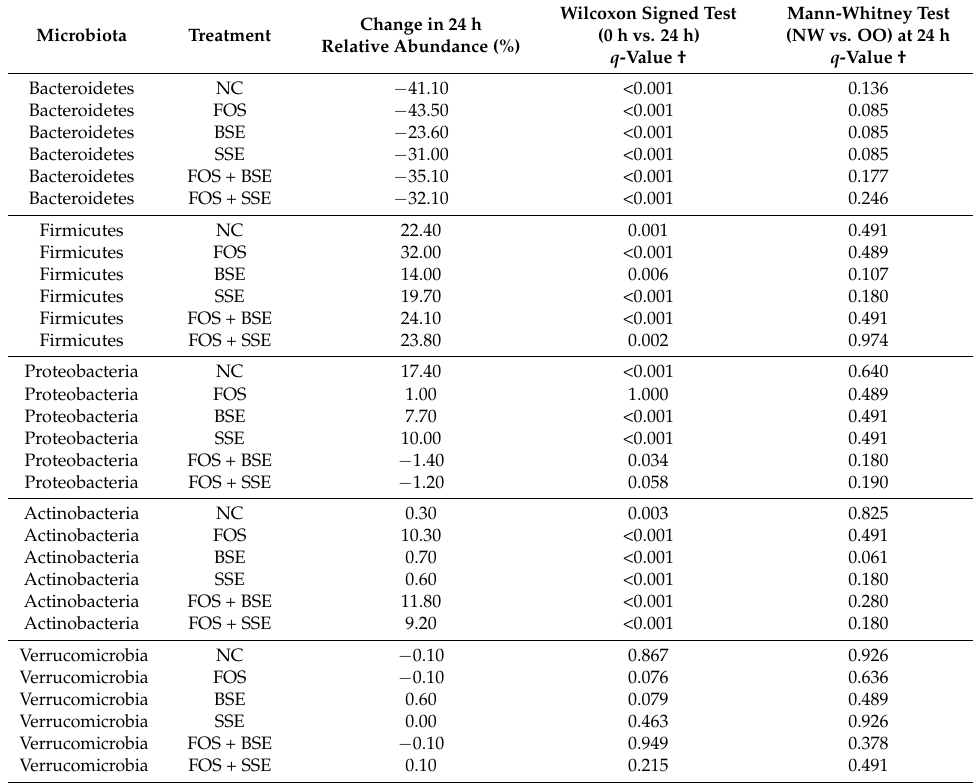
Table 3. The effects of time and weight class in dominant phyla.